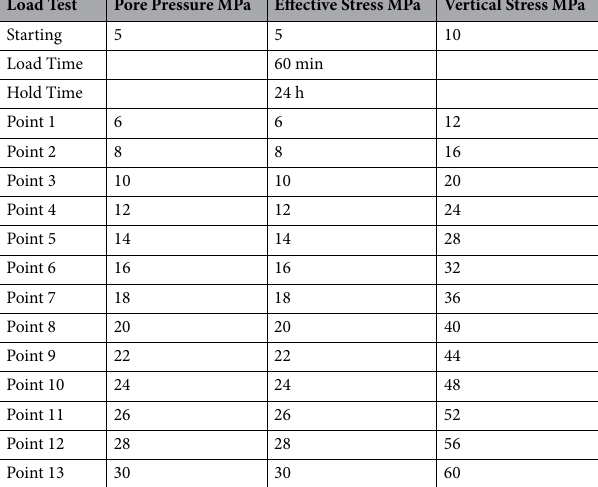
Table 1. Parameters of each experimental point in the loading